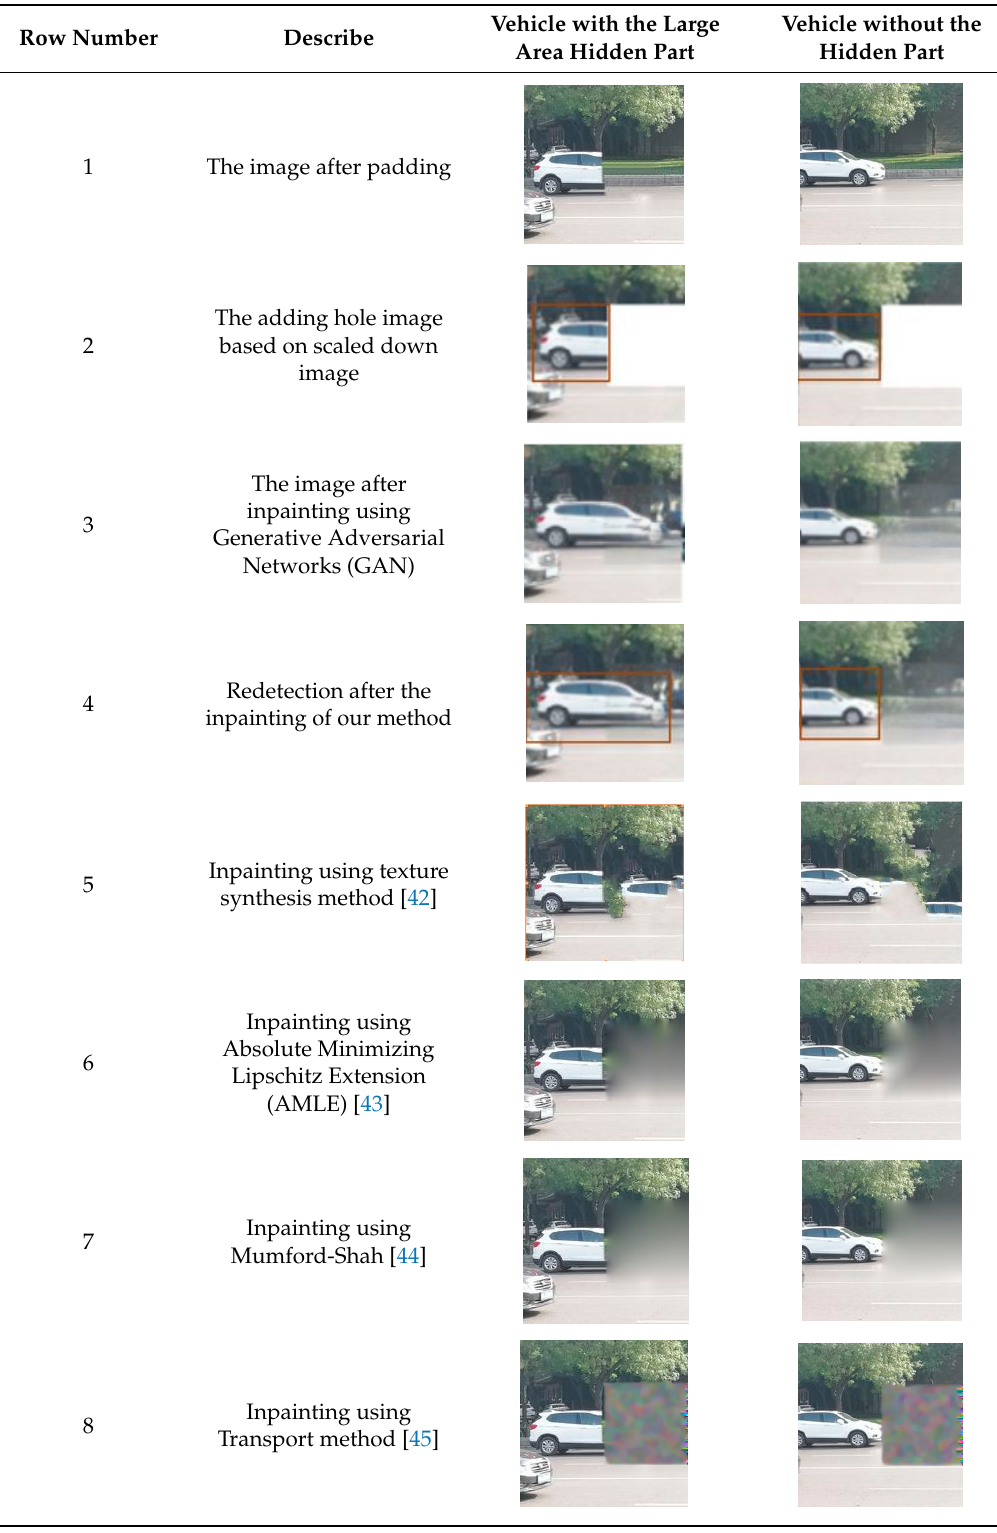
Table 1. The result of the inpainting and the re-detection.